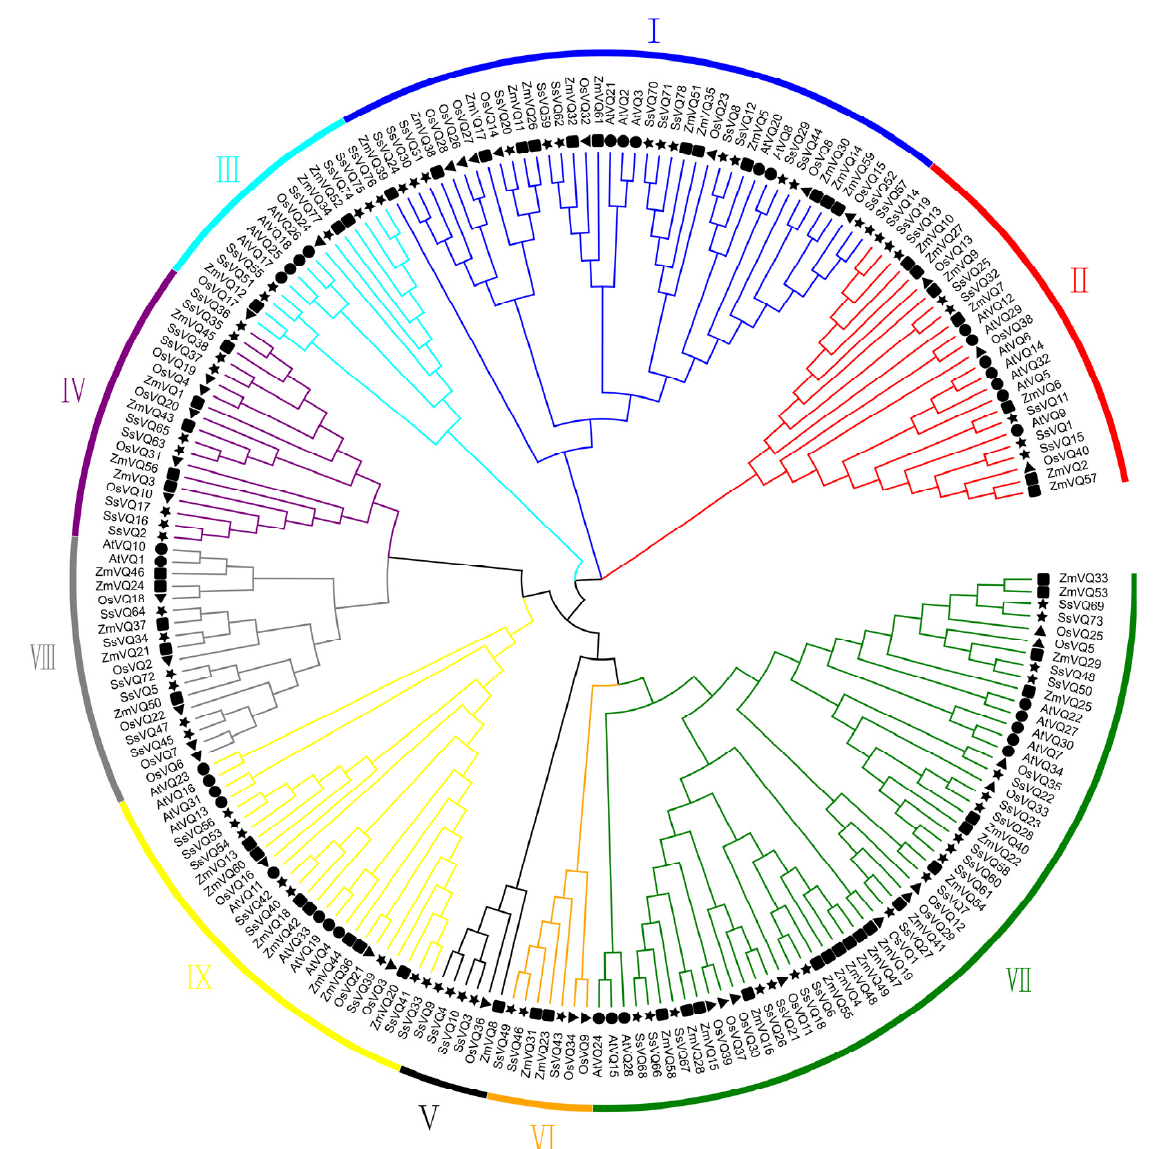
Figure 1. Phylogenetic analysis and family classification of the VQ domains. The NJ tree was constructed using MEGA X with 1000 boosted replicates. The different colored arcs indicate different groups of the VQ domain. Proteins from AP85-441 ( S. spontaneum ), maize ( Zea mays ), rice ( O. sativa ) and Arabidopsis are represented by stars, squares, triangles and circles, respectively.